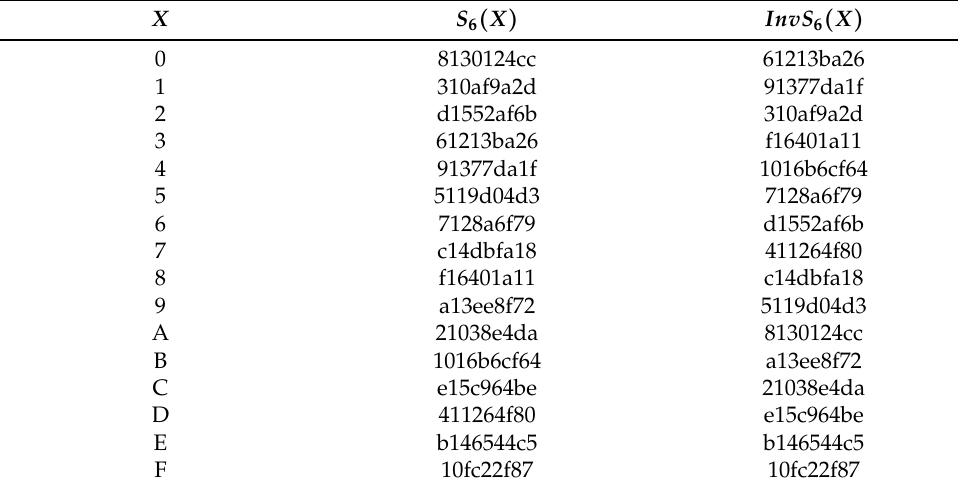
Table 16. New generated 32-bit output S-Box to replace Table 7.